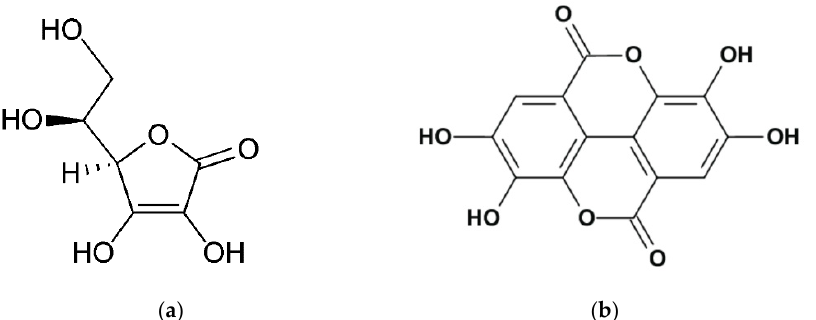
Figure 1. ( a ) Ascorbic acid (AA) chemical structure; ( b ) Ellagic acid (EA) chemical structure.